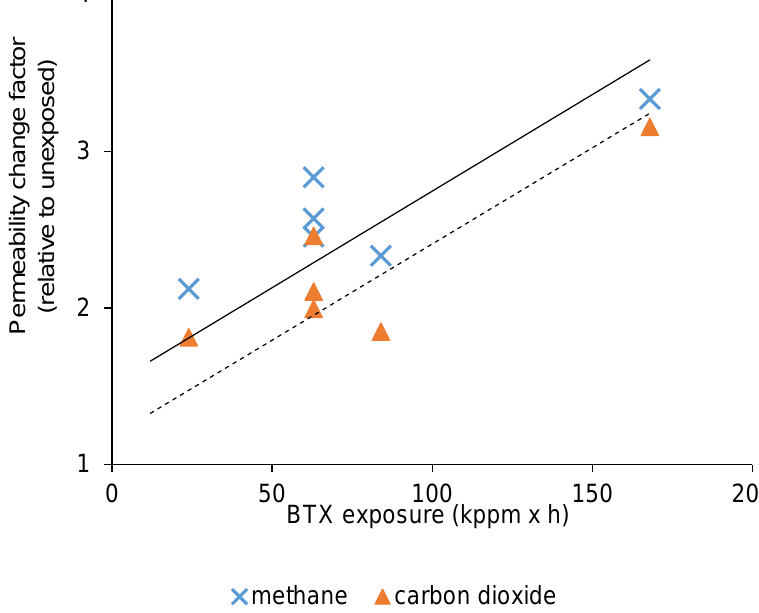
Figure 6. Alteration of gas permeabilities after exposures to benzene, toluene, and xylene (BTX) (the dotted trend line belongs to CO 2 ).